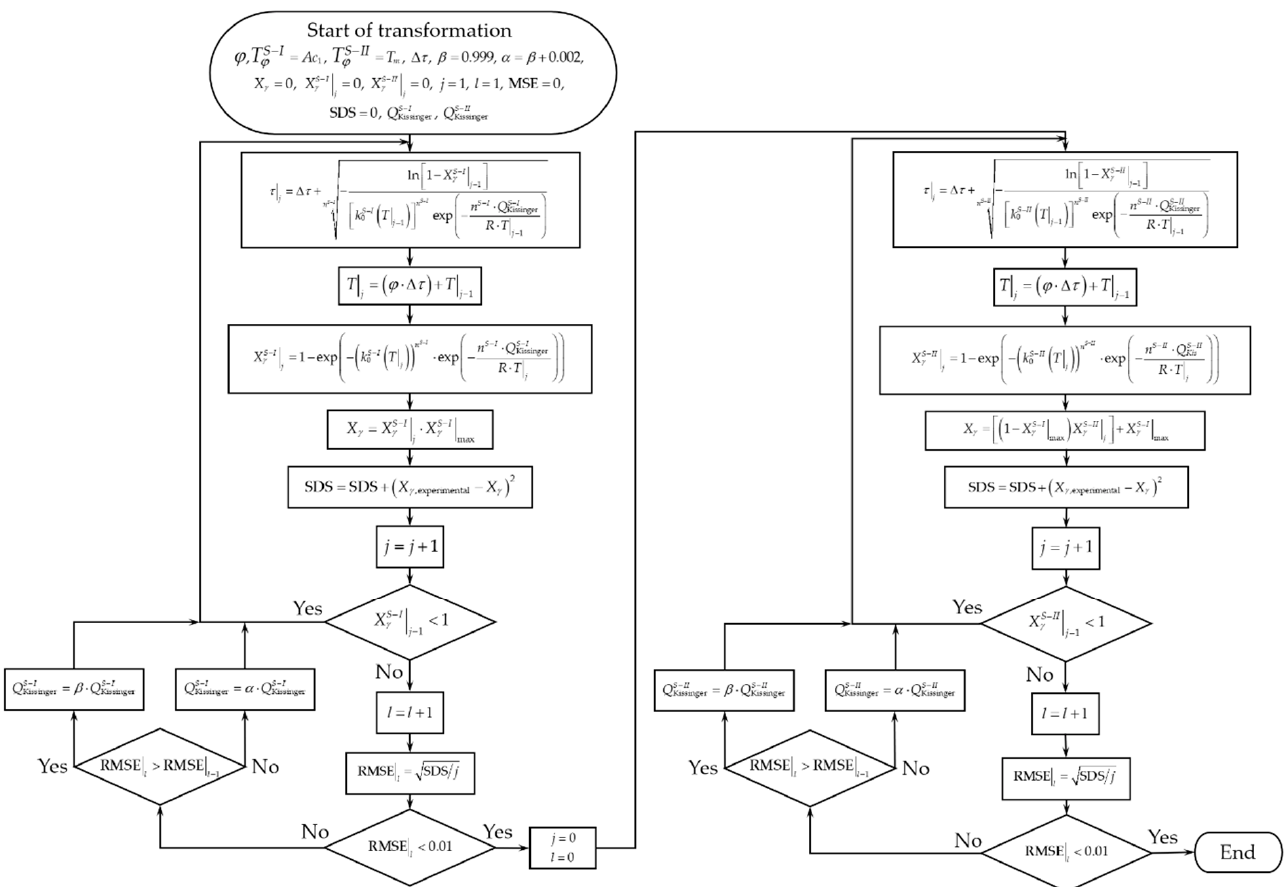
Figure 8. Solution algorithm using the non-isothermal model to estimate the austenite formation degree by stages.